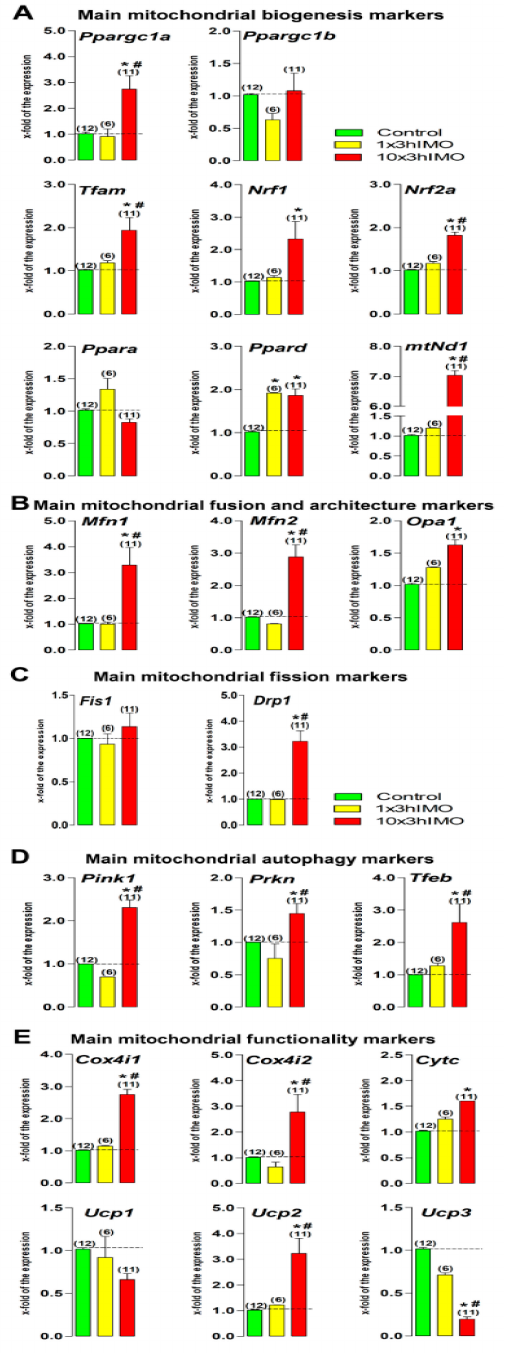
Figure 2. The transcriptional profiles of mitochondrial dynamics and functionality markers are sig- nificantly changed in spermatozoa of repeatedly stressed adult rats. RNA isolated from spermatozoa obtained from undisturbed and stressed rats were used for analysis of the transcriptional profile of markers of mitochondrial biogenesis ( A ), mitochondrial fusion and architecture ( B ), mitochon- drial fission ( C ), mitochondrial autophagy ( D ), and mitochondrial functionality ( E ). Data bars are mean ± SEM values of three independent in vivo experiments. Statistical significance was set at level p < 0.05: * vs. control group; # vs. 1 × 3hIMO